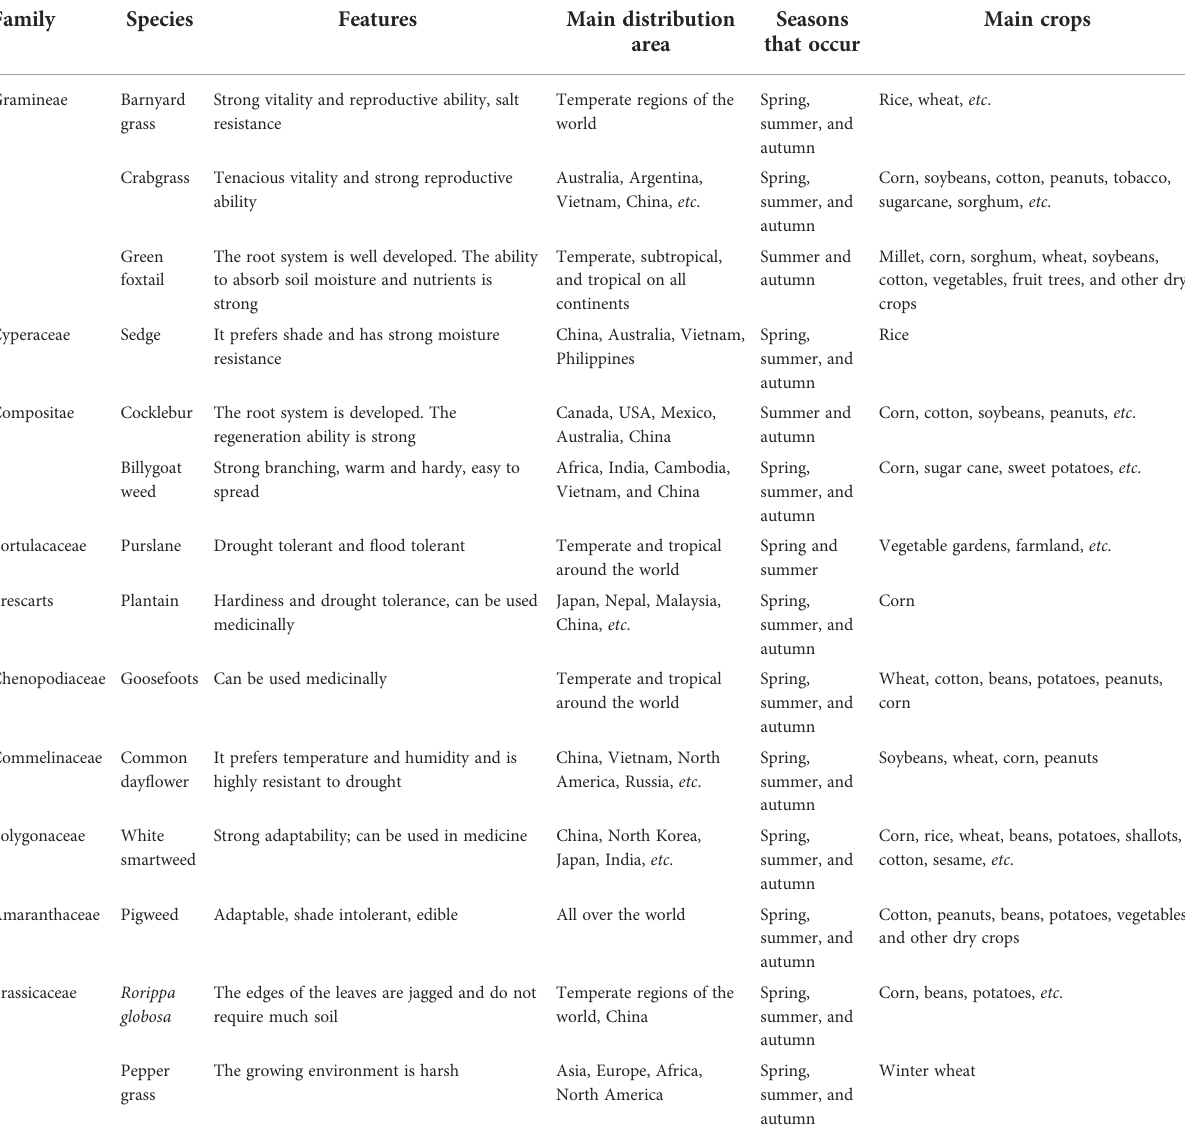
TABLE 1 Some of the main crops with weed growth characteristics and hazards. Family